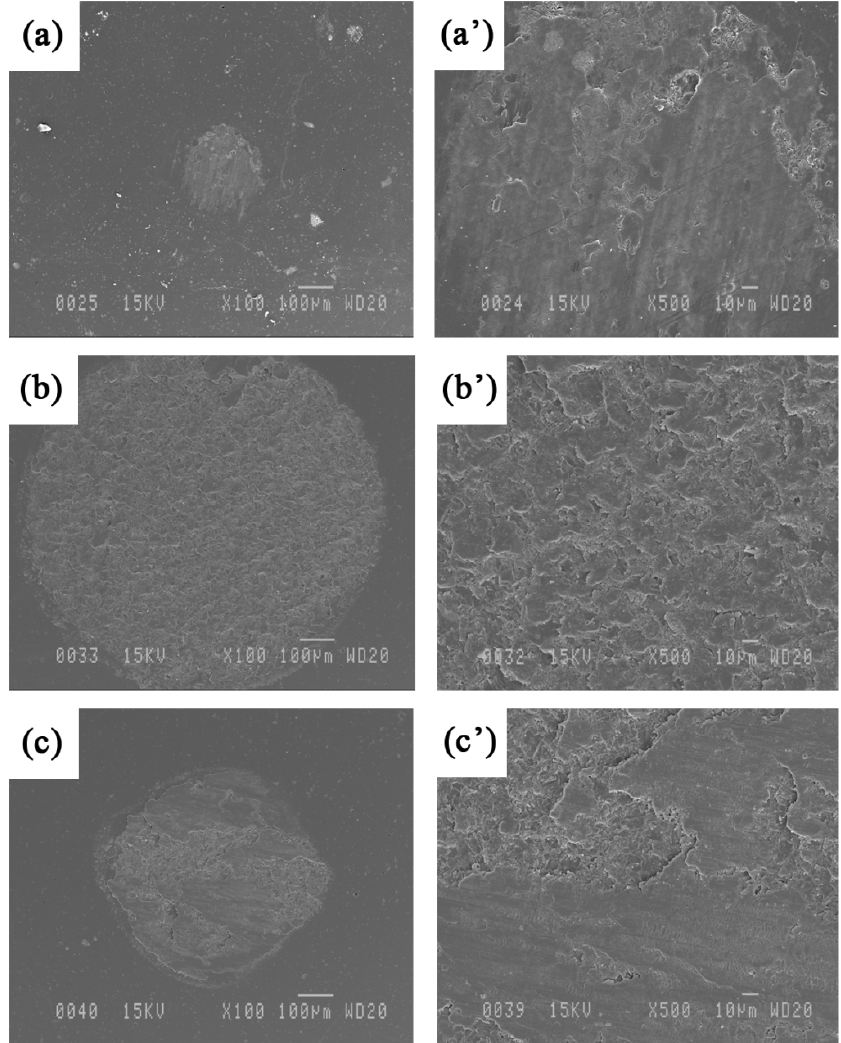
Figure 15. SEM images at different magnifications of the alumina counterpart used against Fe 3 Al ‐ 50 vol.% TiB 2 at a sliding speed of ( a and a’ ) 0.04, ( b and b’ ) 0.3 and ( c and c’ ) 0.8 m s − 1 under 5 N load.